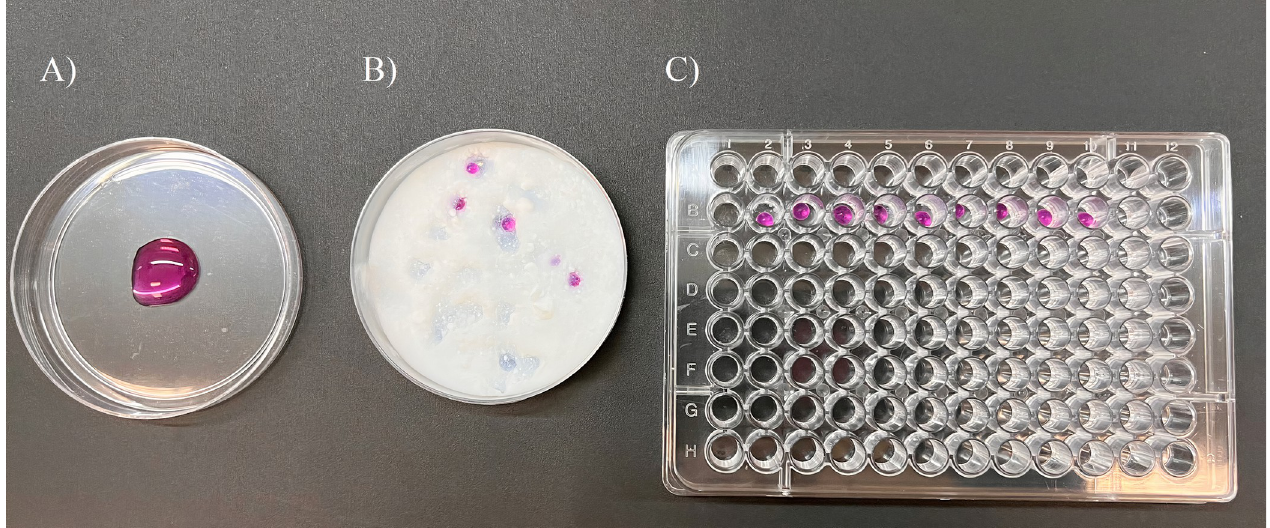
Fig 1. Liquid marble (LM) culture system. For both experiments (IVM or IVC), the LM system was performed in the same way, just changing the number of structures inside the microbioreactor. A) The structures to be cultured (COCs or presumptive zygotes) were all placed inside the same drop of culture medium in a petri dish. B) A total if 6 COCs (experiment I—IVM) or 3 presumptive zygotes (experiment II—IVC) were picked up in a 30 μ l of culture medium and placed in contact with the CAB-O-SIL 1 TS-530 fumed silica powder to coat the drops. C) The drops were transferred using a 1000 μ l pipette to a 96-well plate to be incubated at 38,5˚C in 5%CO 2